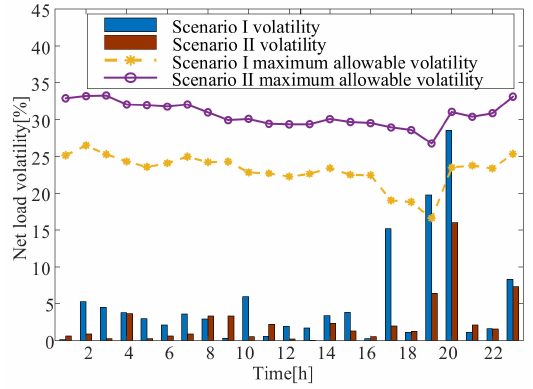
Figure 11. Net load volatility curves of two